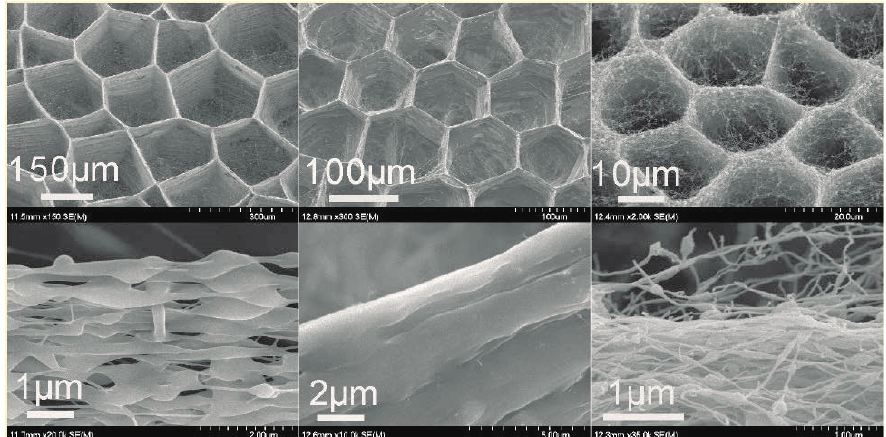
Figure 3. Scanning electron microscope (SEM) images showing honeycomb-like structures of poly(vinyl acetate) (PVA) and poly(ethylene oxide) (PEO). Reprinted with permission from [30], Copyright © 2011, American Chemical